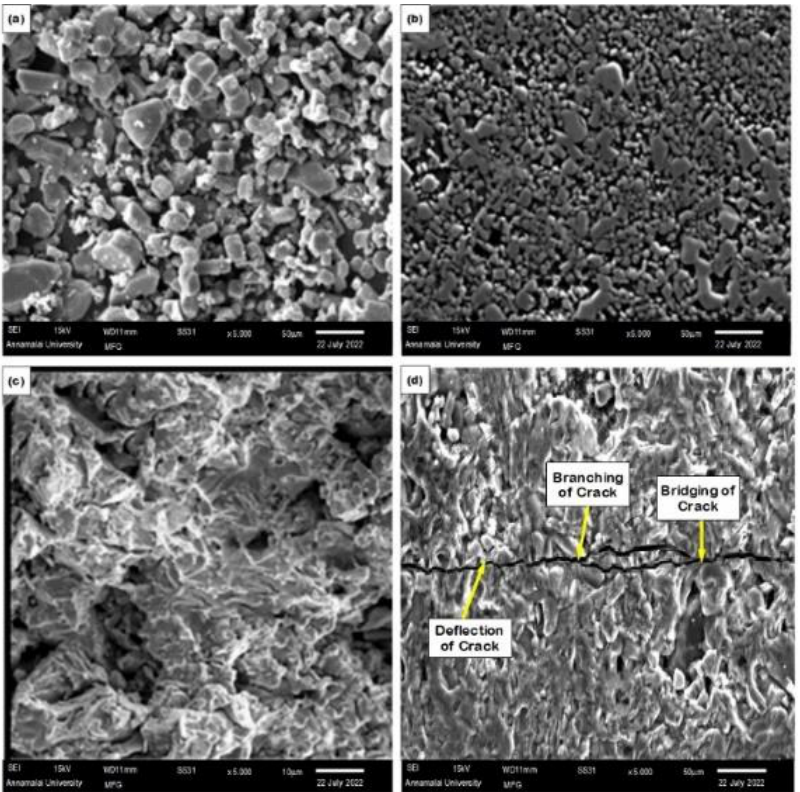
Figure 13. SEM image showing fractured surface of: ( a ) TiB 2 -15Si 3 N 4 -3B 4 N, ( b ) TiB 2 -15Si 3 N 4 -6B 4 N, ( c ) TiB 2 -30Si 3 N 4 -3B 4 N, and ( d ) TiB 2 -30Si 3 N 4 -6B 4 N.